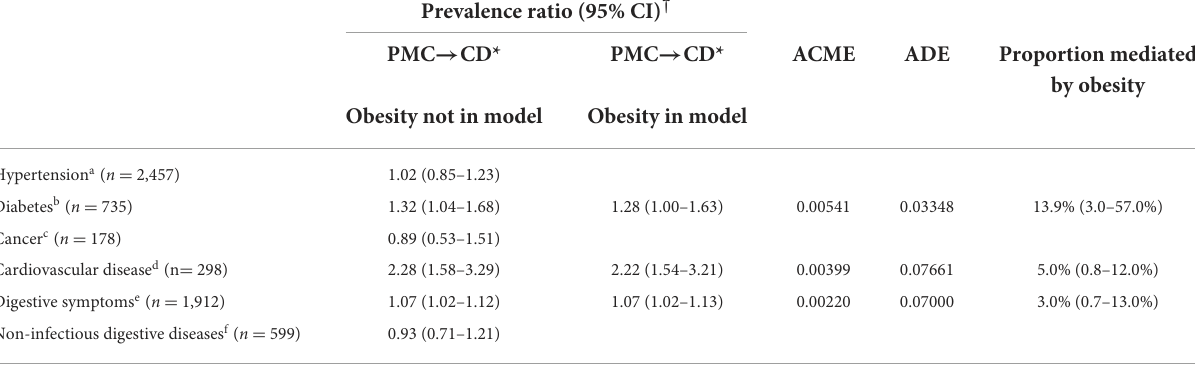
TABLE 6B Mediation analysis of the relationship between processed meat consumption and chronic diseases using obesity as a